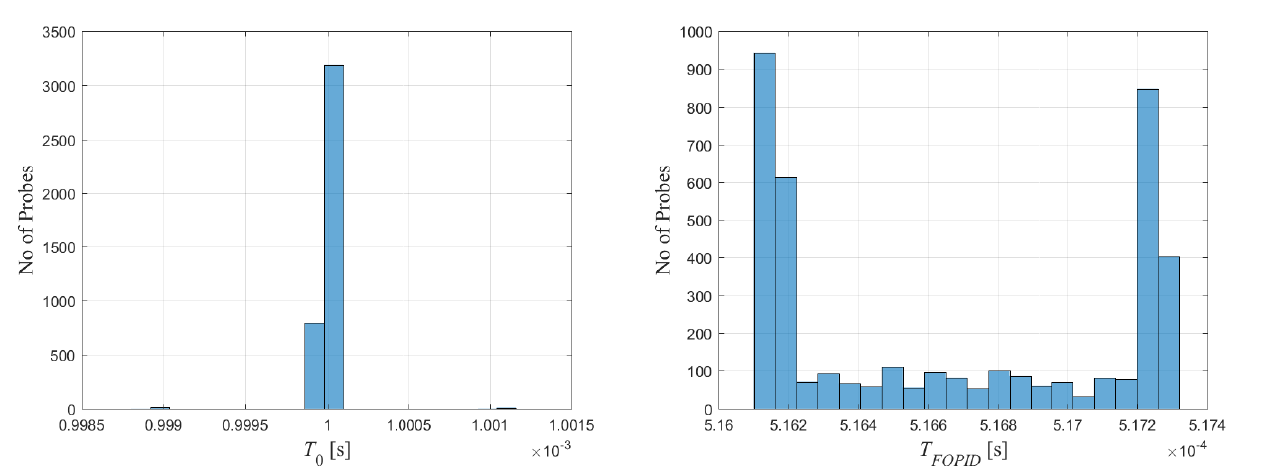
Figure 7. Duration of calculations using FOBD.